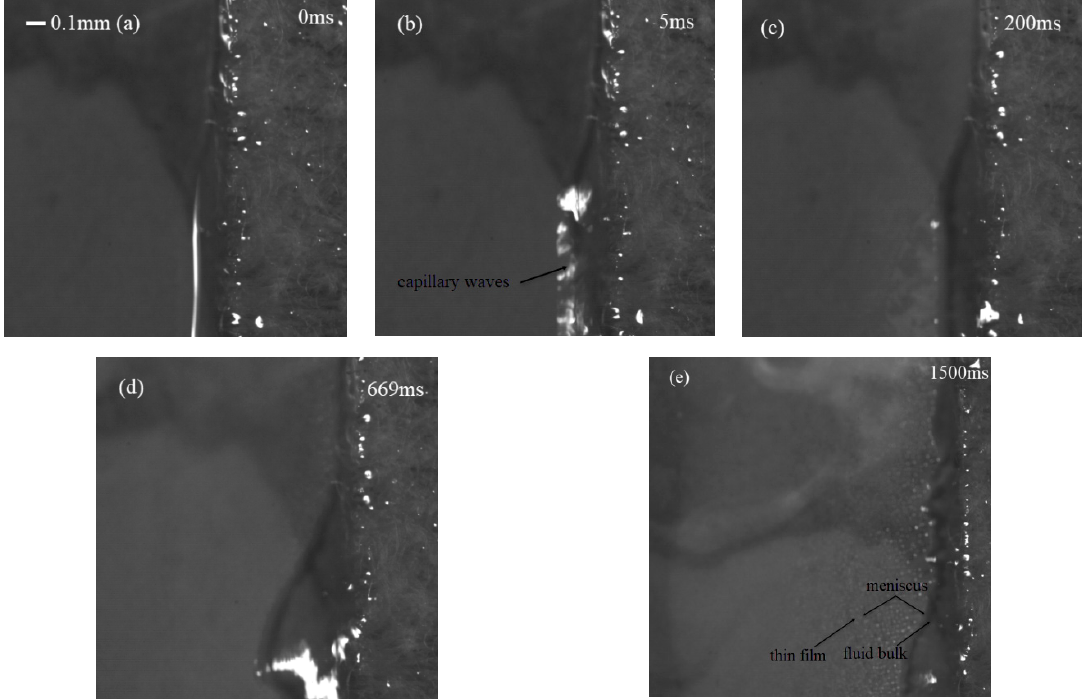
Figure 8. A high-magnification image of the movement of the liquid on the paper. ( a ) 0 ms, ( b ) 5 ms, ( c ) 200 ms, ( d ) 669 ms, ( e ) 1500 ms.